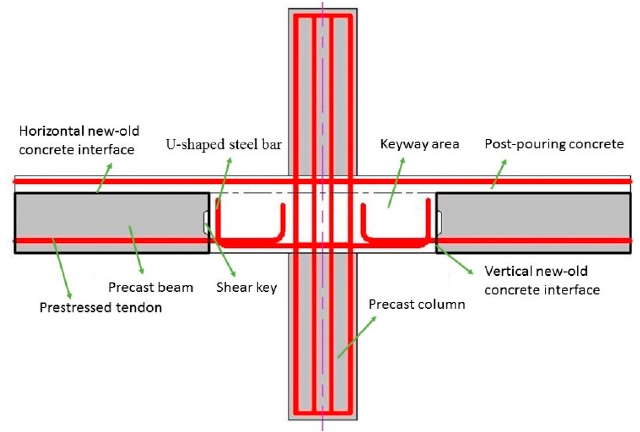
Figure 1. Precast prestressed concrete joint.